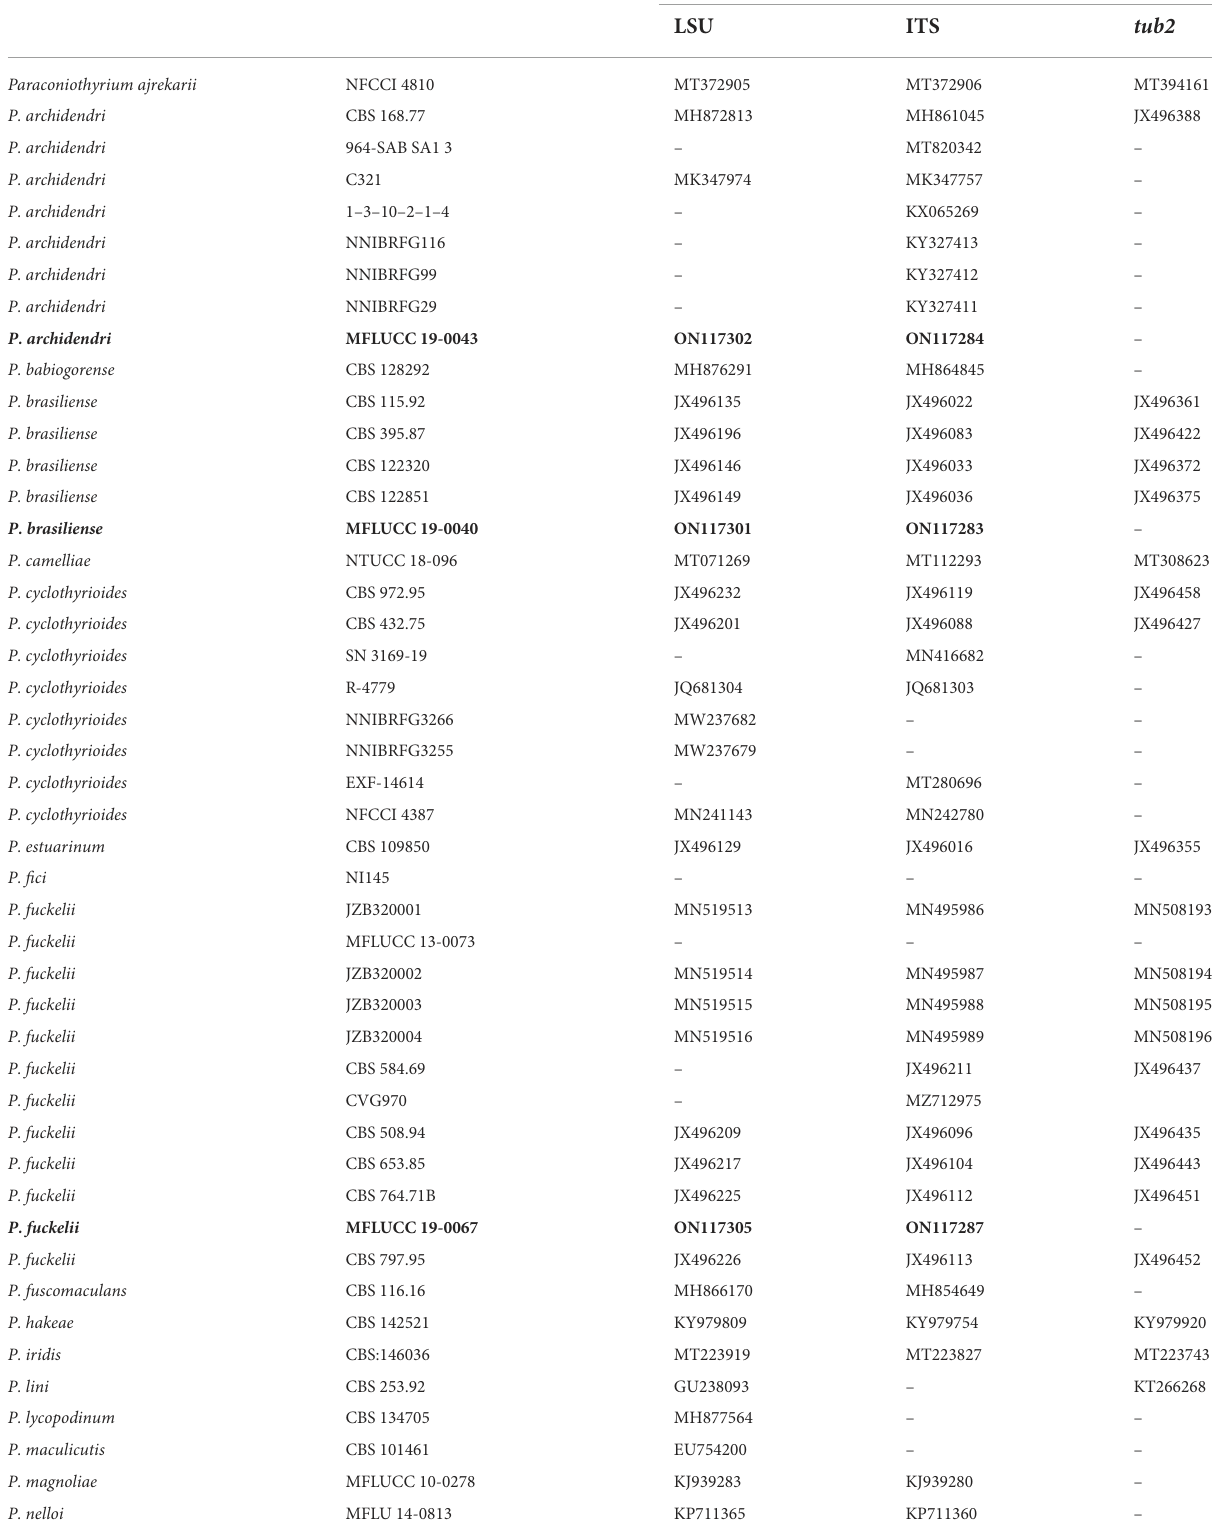
TABLE 2 GenBank and culture collection accession numbers of species included in this phylogenetic study ( Paraconiothyrium tree).